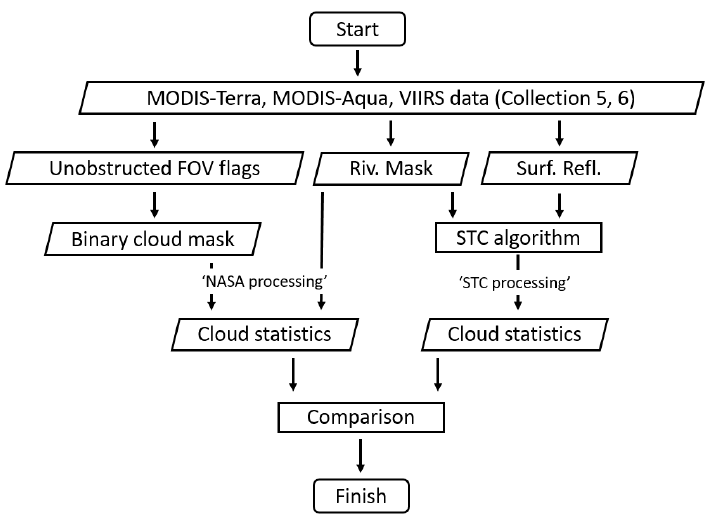
Figure 1. Overview of the approach used, detailing data and processes used to obtain the cloud statistics for NASA and STC processing. FOV stands for field-of-view.